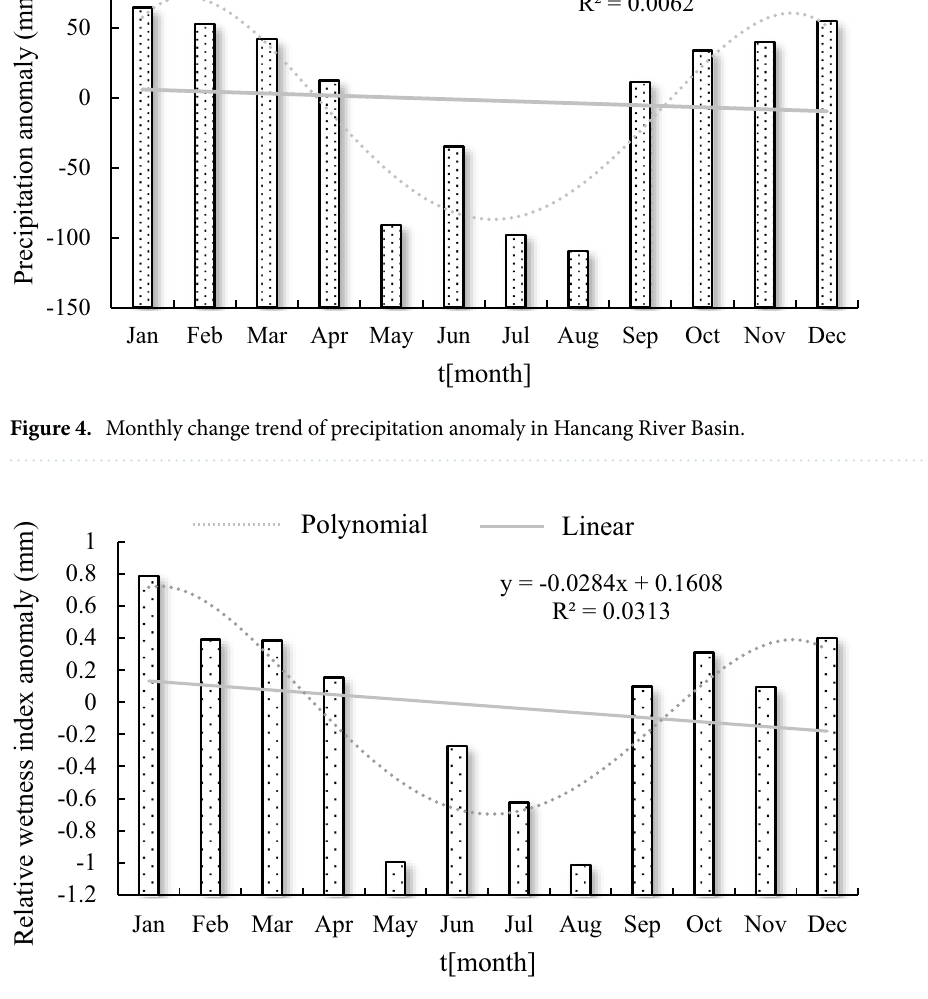
Figure 5. Monthly relative humidity index anomaly in Hancang River